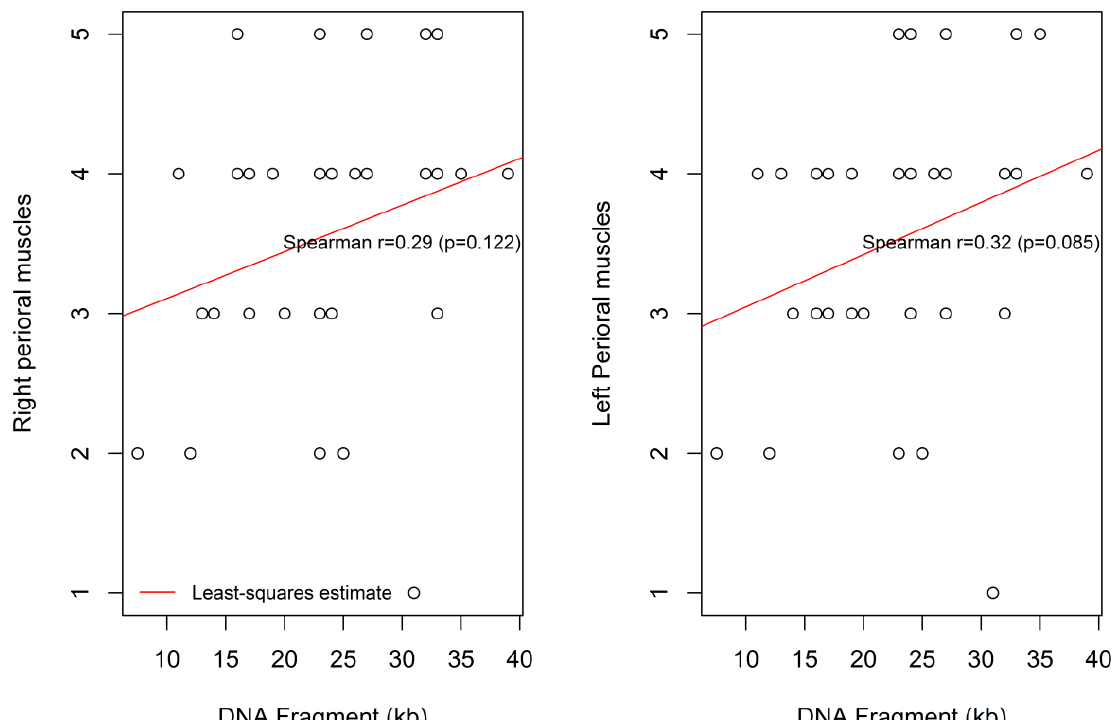
Figure 5. Correlation between the DNA fragment size and the degree of the left and the right perioral muscle weakness.